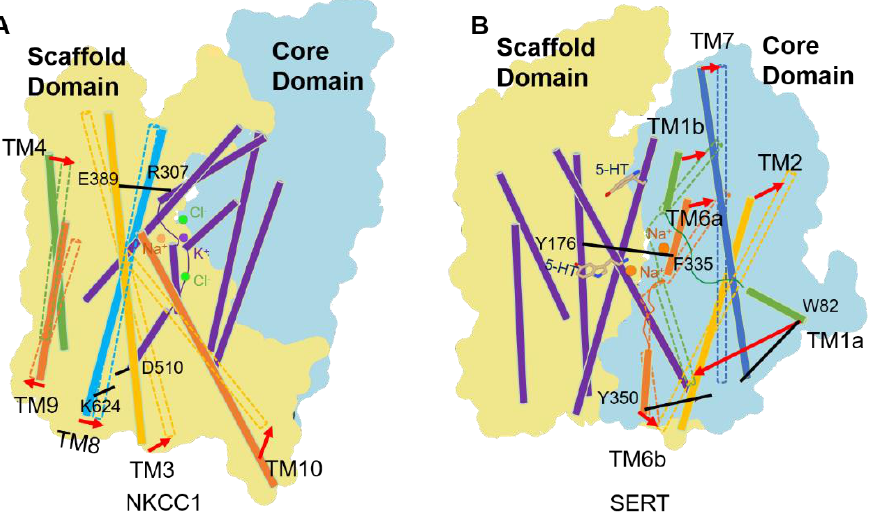
Figure 4. Comparison of alternate access model for ( A ) NKCC1 and ( B ) SERT. NKCC1 and SERT show opposite mobile domain vs. static domain when they isomerize between inward and outward open states. Static helices are shown in purple. Ions are shown as spheres, substrate 5-HT is rendered as sticks. Movements of helices are indicated as arrows. Residues that gate access and escape of substrates are also